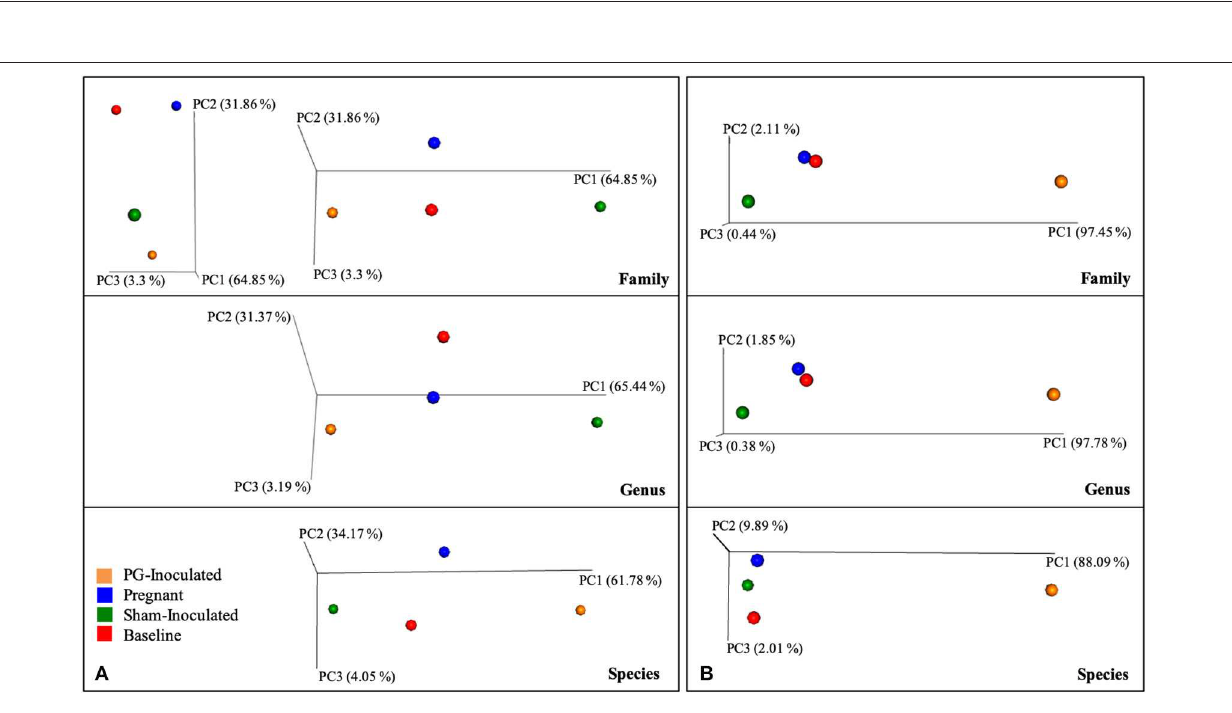
Frontiers in Cellular and Infection Microbiology |